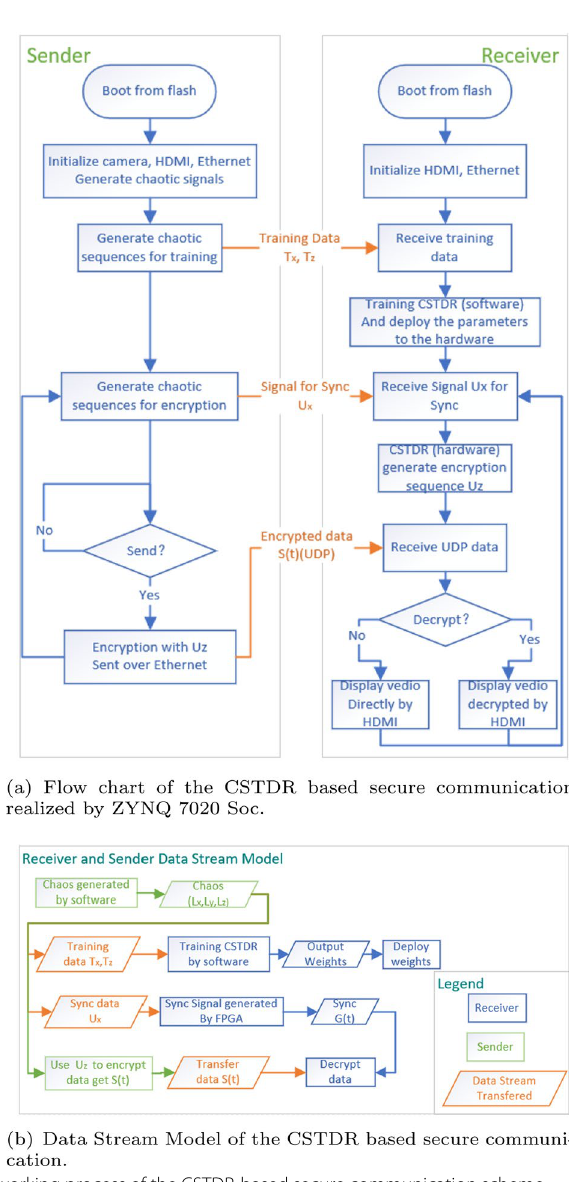
the feasibility of the scheme. By using ZYNQ 7020 Soc, the communication scheme is experimentally realized by hardware, which provides a more practical model on how to utilize our paradigm in reality. The work not only provides a deep RC models based on TDR but also extends the machine learning approach into practical applications, shedding light on the exploration of the intrinsic dynamics of deep TDRs and bespoke